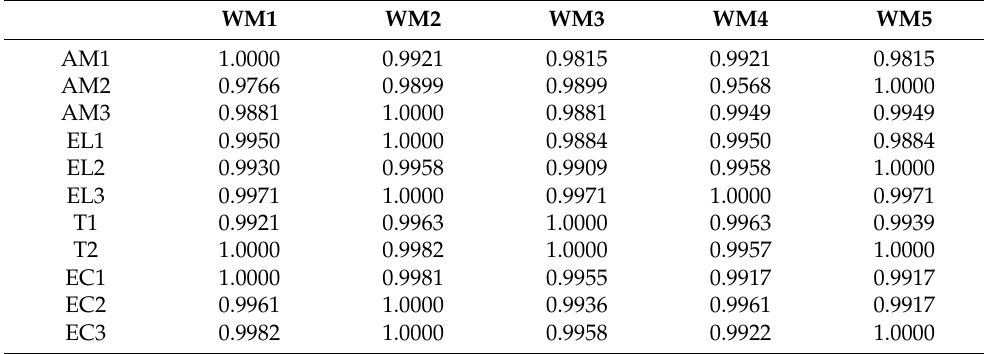
Table 6. Weighted Aggregated Sum Product Assessment judgment matrix for multiplier parts, weighed and normalized.